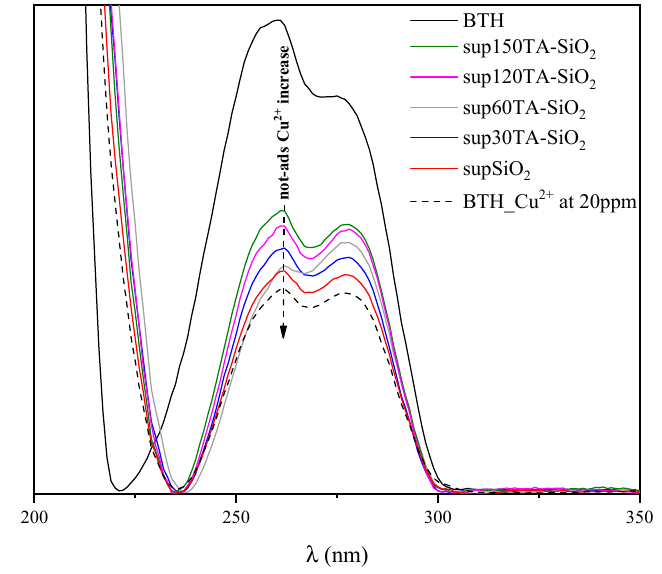
Figure 7. Baseline subtracted UV-vis absorption spectra of BTH; BTH/Cu 2+ complex and super- natants solutions of SiO 2 , 30TA-SiO 2 , 60TA-SiO 2 , 120TA-SiO 2 and 150TA-SiO 2 NPs.